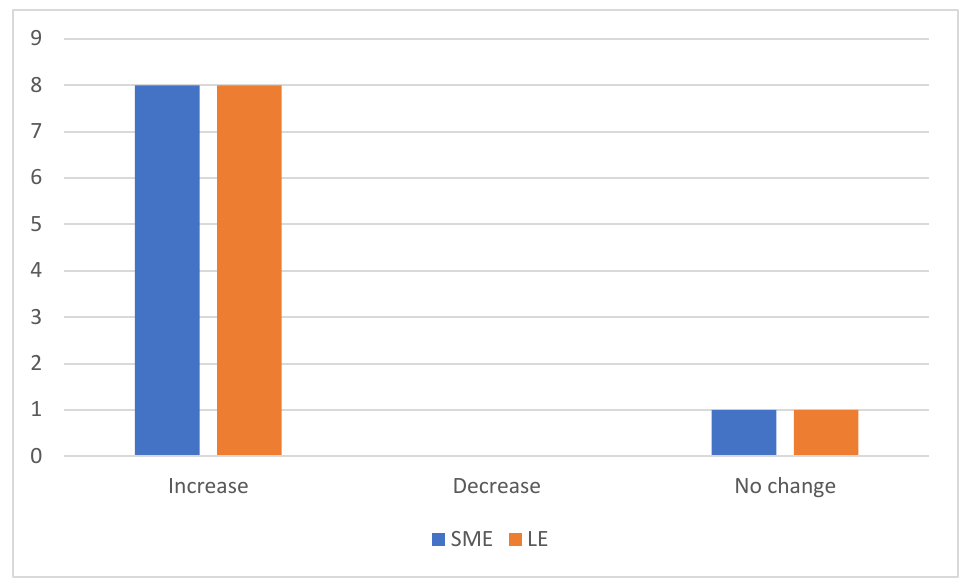
Figure 1. Participants’ responses to questions on the impact of IoT on sales and customer satisfaction in small and medium-sized (SME) and large enterprises (LE).